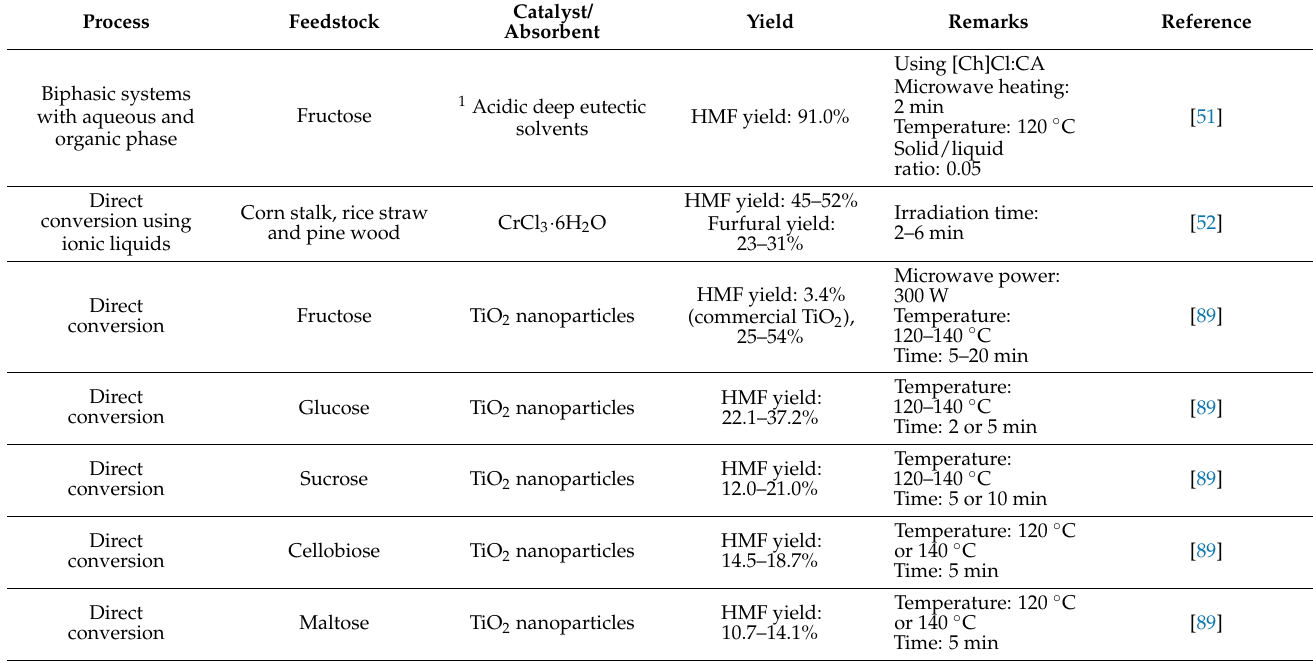
Table 8. Sugar conversion using microwave-assisted